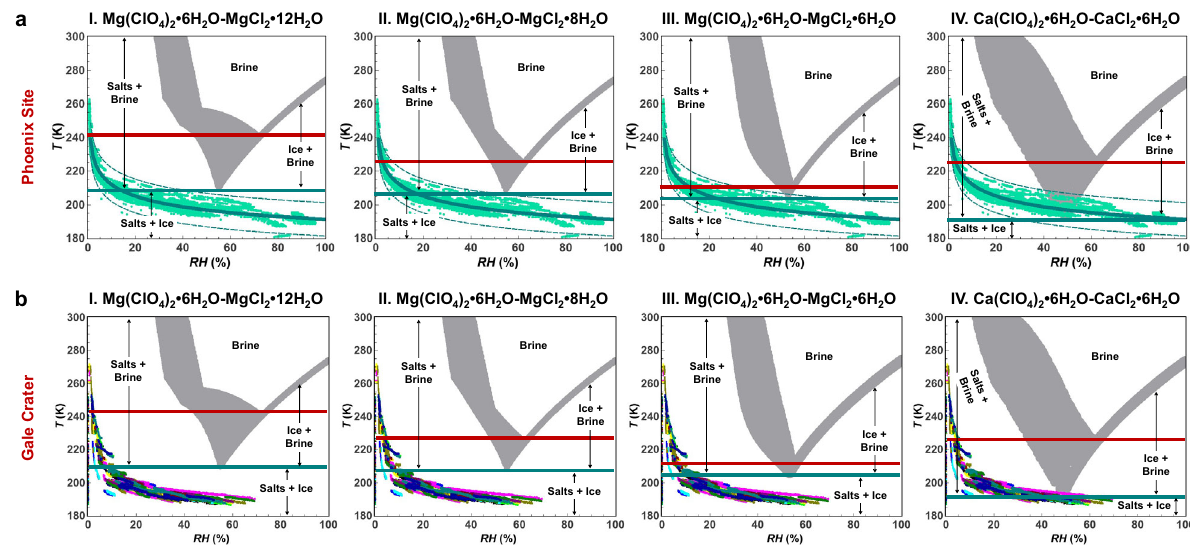
Fig. 2 Deliquescence-induced brine formation at the Phoenix landing site and Gale Crater. a In situ RH- T data of the Phoenix landing site are overlaid onto the deliquescence surfaces of the salt mixtures. I: Mg(ClO 4 ) 2 (cid:129) 6H 2 O + MgCl 2 (cid:129) 12H 2 O; II: Mg(ClO 4 ) 2 (cid:129) 6H 2 O + MgCl 2 (cid:129) 8H 2 O; III: Mg(ClO 4 ) 2 (cid:129) 6H 2 O + MgCl 2 (cid:129) 6H 2 O; and IV: Ca(ClO 4 ) 2 (cid:129) 6H 2 O + CaCl 2 (cid:129) 6H 2 O. The dark gray regions are the projection of the ternary deliquescence surfaces, and the dark cyan and dark red horizontal lines are the projections of the lower- and upper- T boundary planes, respectively, as shown in Fig. 1. The green dots are in situ RH -T measurements. The thick solid dark-cyan curve is the best fi t line, and the thin dashed dark-cyan curves are the 10K uncertainty boundaries. Salt mixtures of Mg(ClO 4 ) 2 (cid:129) 6H 2 O-MgCl 2 (cid:129) 6H 2 O and Ca(ClO 4 ) 2 (cid:129) 6H 2 O-CaCl 2 (cid:129) 6H 2 O may facilitate the formation of brines with elevated ClO 4 − /Cl − signatures. b In situ RH -T data of Gale Crater overlaid on the deliquescence surfaces of the salt mixtures. The dark gray ternary deliquescence surfaces and the lower- and upper- T boundary lines of sub fi gures I to IV are the same as shown in ( a ). The colored dots are the in situ RH- T data (REMS; sols 526, 531, 548, 549, 551, and 554 to 561 with maximum yearly humidity). The RH- T conditions of the fi rst Martian year at Gale Crater would support the deliquescence of Ca(ClO 4 ) 2 (cid:129) 6H 2 O-CaCl 2 (cid:129) 6H 2 O but not for any of the Mg salt